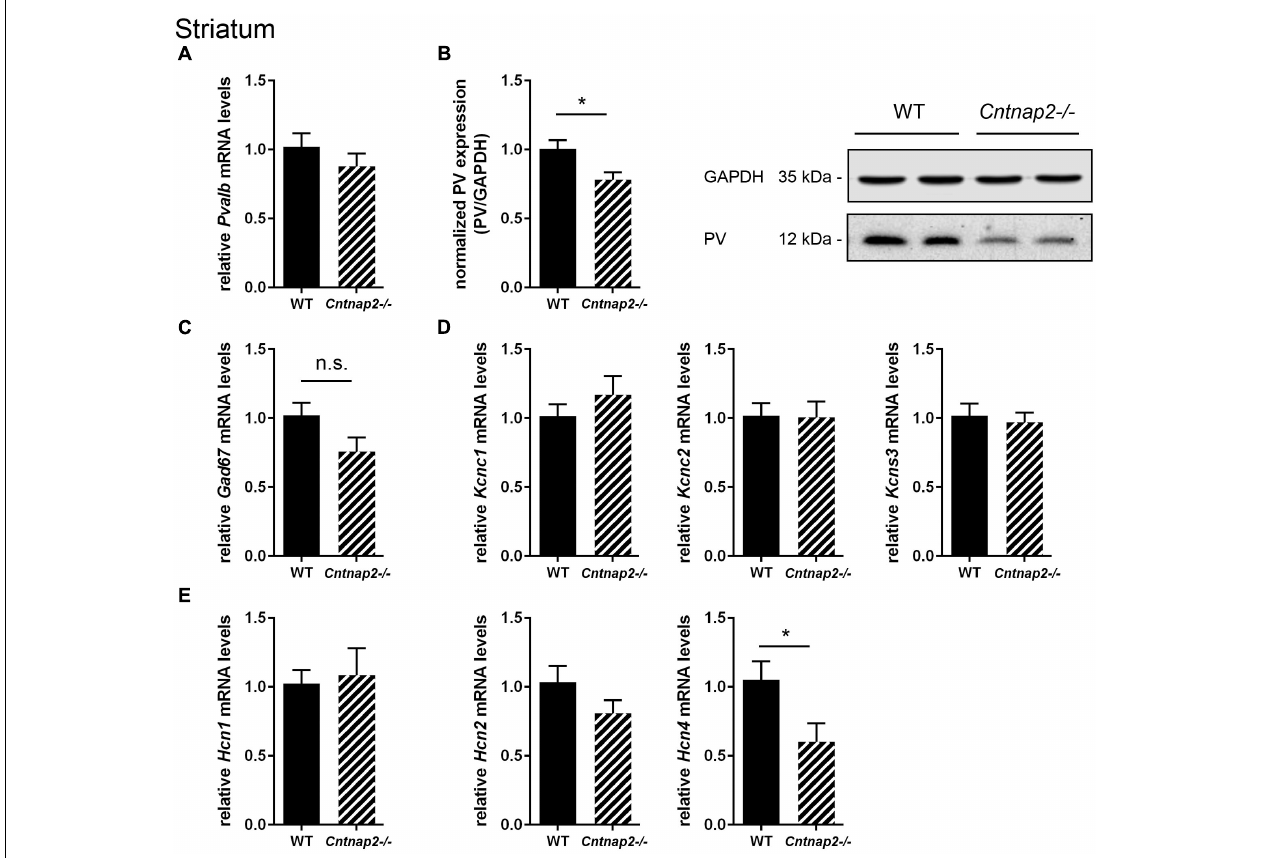
FIGURE 2 | RT-qPCR values from striatal samples of PND25 mice representing mRNA levels for (A) Pvalb , (C) Gad67 , (D) Left: Kcnc1 ; Middle: Kcnc2 ; Right: Kcns3 , (E) Left: Hcn1 ; Middle: Hcn2 ; Right: Hcn4 . Signals were normalized to Gapdh mRNA levels and expressed as fold change compared to WT ( N = 6 mice each). (B) Left: Quantitative Western blot analysis of striatal samples of PND25 WT and Cntnap2–/– mice ( N = 6 mice each). Quantification of PV protein levels in the striatum is shown. Asterisks represent ∗ P ≤ 0.05. GAPDH signals served as loading controls and were used for the normalization of PV protein signals. Results are expressed as a percentage of normalized PV/GAPDH signals in the WT group. Right: Representative Western blot signals for PV and GAPDH are shown. All data are expressed as mean ±